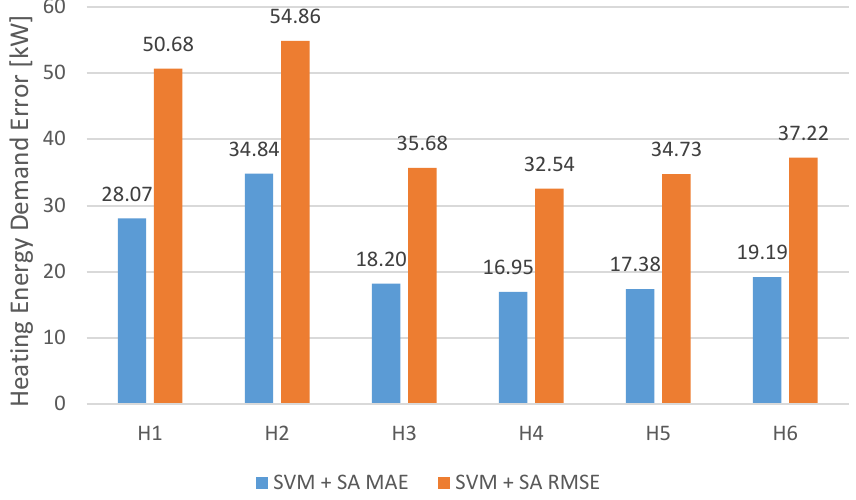
Figure 18. Error metrics for heating energy demand using SVM + SA.